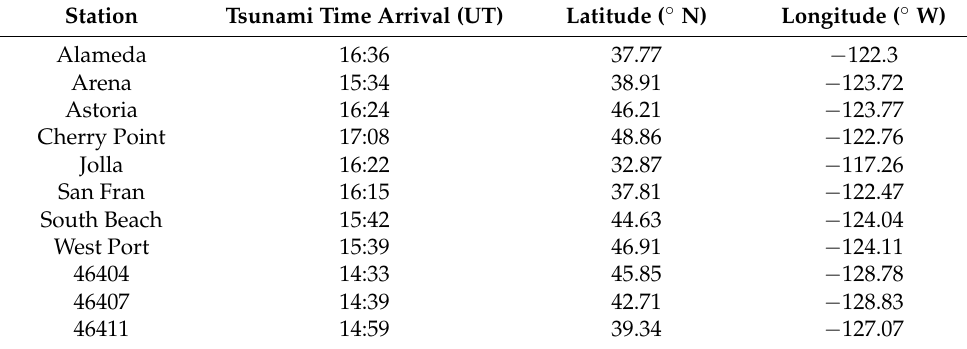
Table 2. Tsunami propagation velocity of